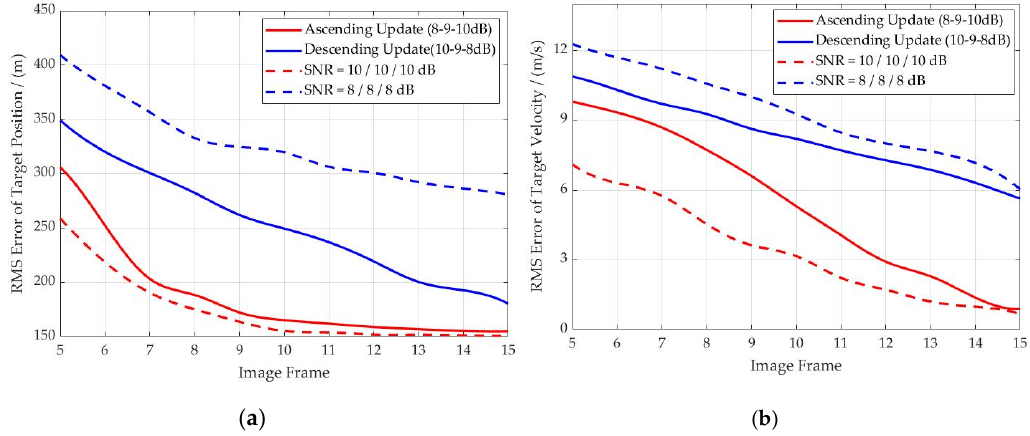
Figure 12. Root mean square (RMS) error of target position and velocity in different update order cases: ( a ) RMS error of target position; ( b ) RMS error of target velocity.